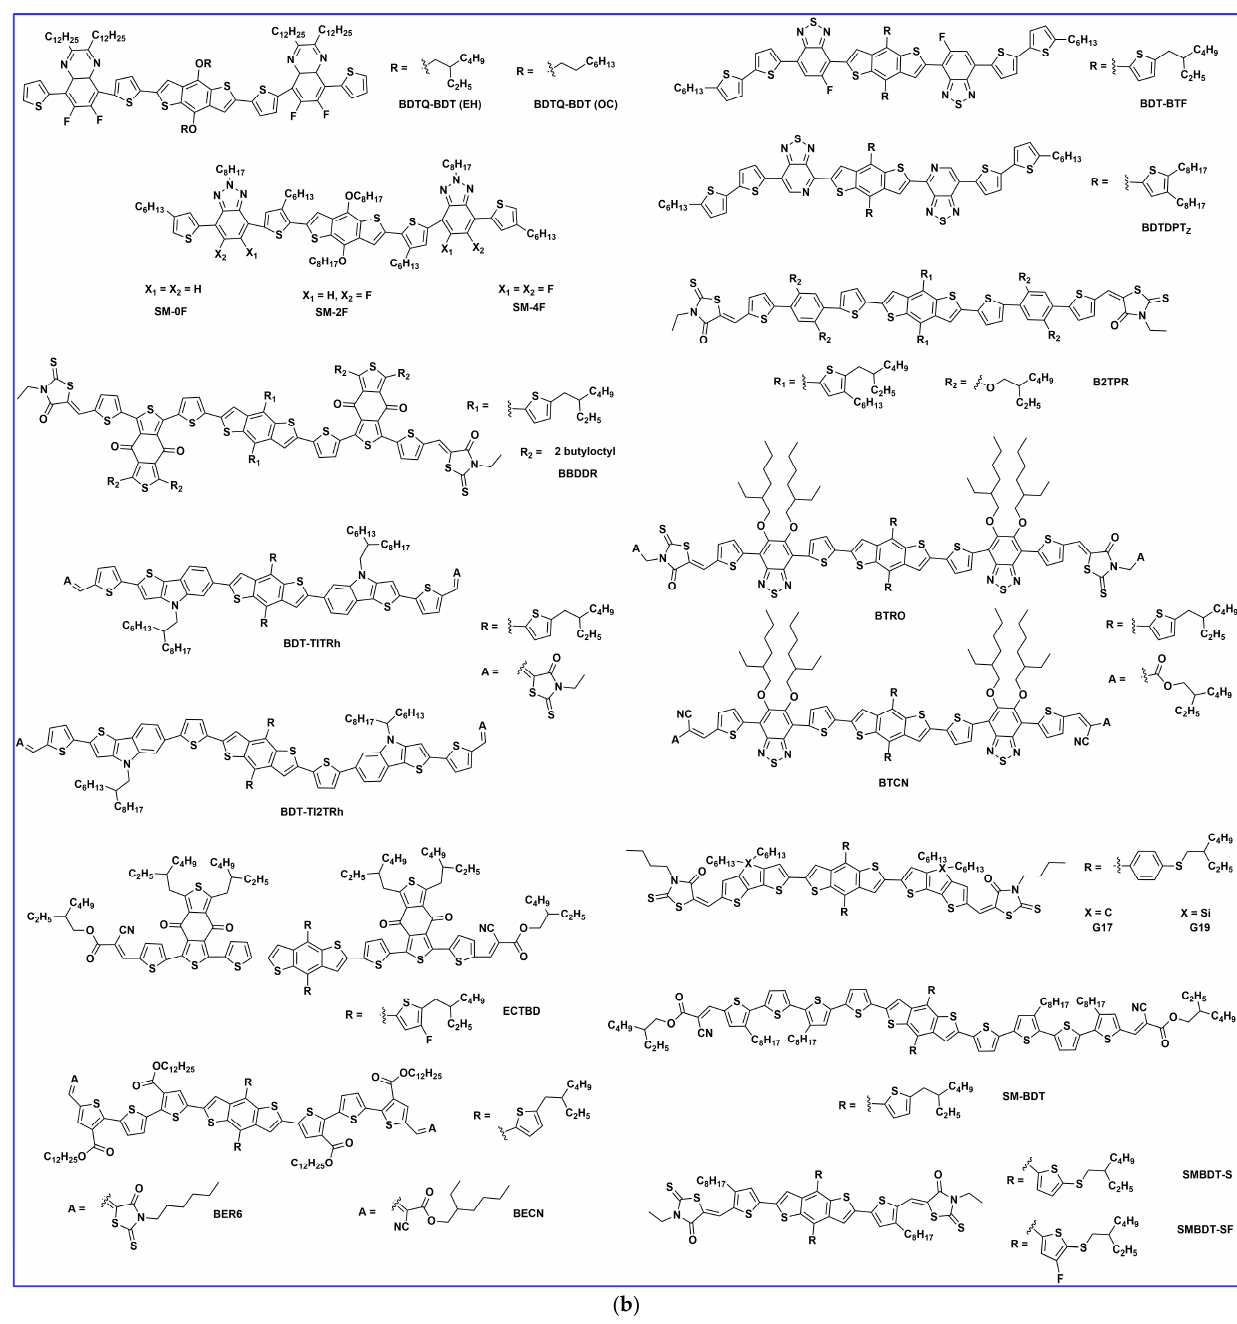
Figure 5. ( a ) BDT molecular structure via π -bridge engineering. ( b ) BDT molecular structure via π -bridge engineering.